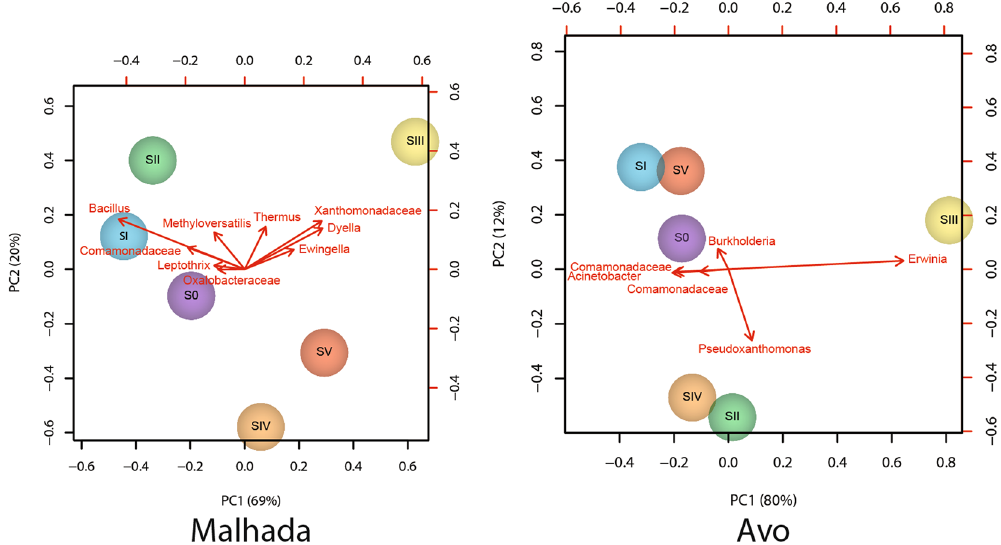
Figure 4. Principal component of endophytic, wood colonizing bacterial communities at different phylogenetic levels from pine trees of six different symptomatic classes from the two sampling areas ( A : Malhada B : Avo) based on sequencing of PCR amplified 16S rRNA gene fragments.